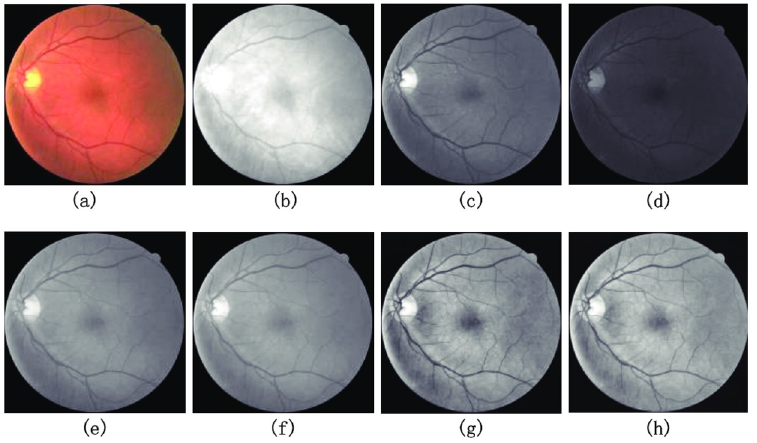
Fig 4. (a) is the original medical image. (b–d) are visualizations of red, green, and blue channels, respectively. Results of each preprocessing strategy. (e) is the image after grayscale processing. (f) is the image after data normalization. (g) is the image after CLAHE operation. (h) is the image after Gaussian